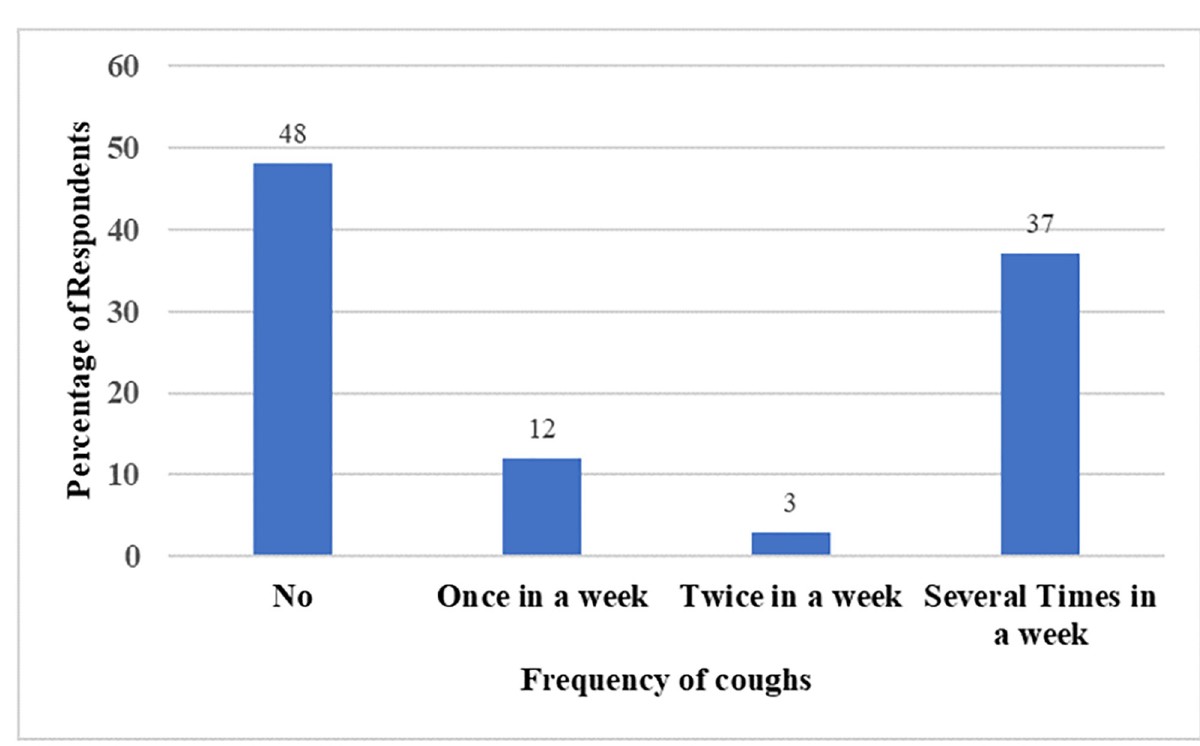
Fig 5. Association between fish smoking and